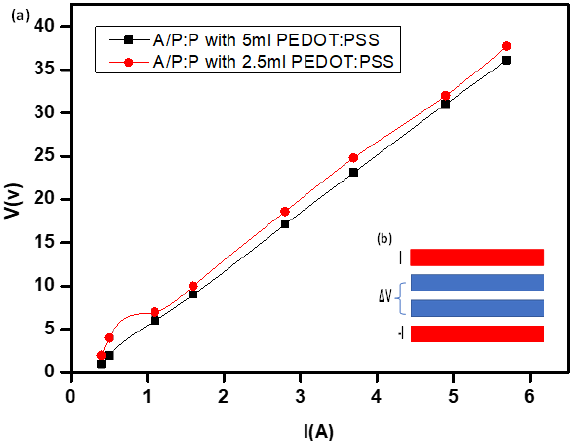
Table 2. Sheet resistance of (A/P:P) at different concentrations of PEDOT:PSS.